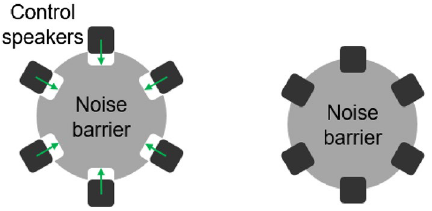
Figure 10. Configuration of the position of the control